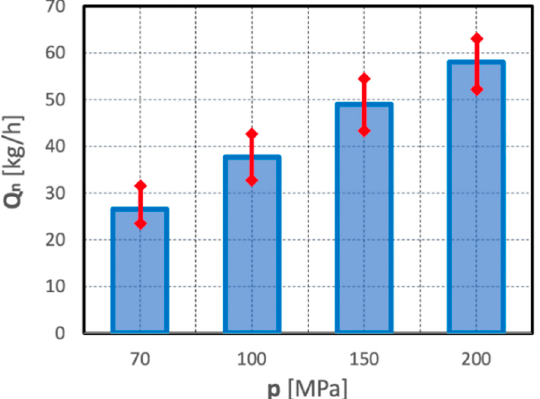
Figure 23. Effect of water jet pressure on the efficiency of the comminution process of polymetallic concretions in a hydro-jet mill (for d w = 0.7 mm, d h = 2.4 mm, s = 10 mm).